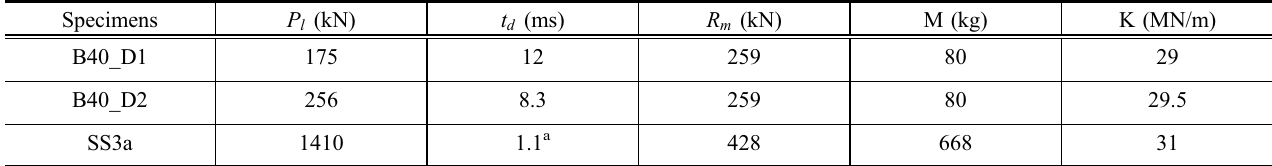
Table 2 Parameter values for equivalent SDOF models.